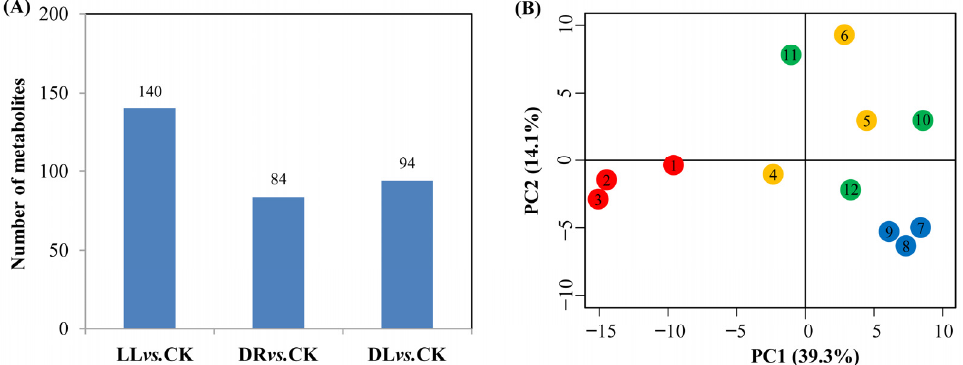
Figure 3. The effects of low light, drought, and their combined stress on metabolites of current-year leaves in Masson pine seedlings: ( A ) numbers of differentially identified metabolites and ( B ) PCA analysis of differentially identified metabolites from four treatments. CK: control; LL: low light; DR: drought; and DL (DR + LL): the combined stress of drought and low light. The numbers in ( B ) 1 − 3 (red), 4 − 6 (orange), 7 − 9 (blue), and 10 − 12 (green) are three repeats of CK, DR, LL, and DL treatments, respectively. Every treatment included three individual repeats, and 20 leaves were collected from each. Detailed information is in Supplementary Table S3.